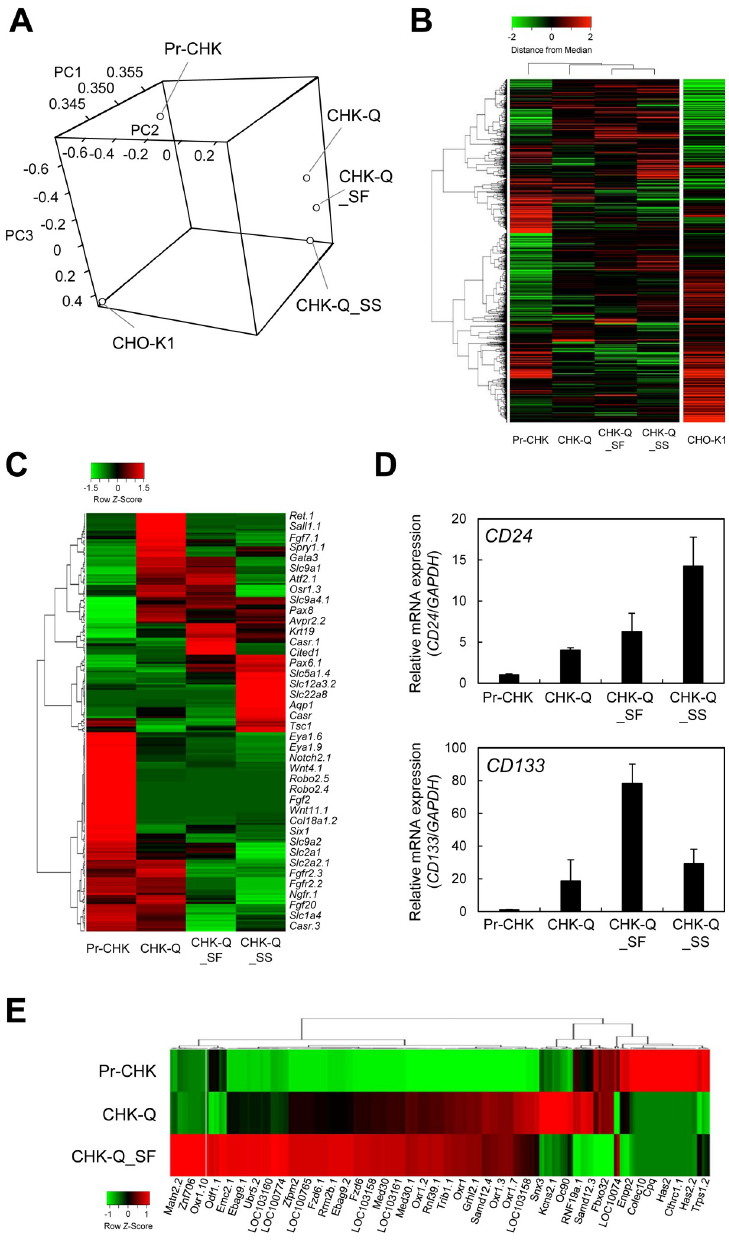
Fig 3. Comparative gene expression analysis using DNA microarrays. (A) Three-dimensional principal component analysis (PCA) for transcriptomic data of pre-immortalized primary cells (Pr-CHK), immortalized cells (CHK-Q), serum-free-adapted cells (CHK-Q_SF), CHK-Q_SS cells that were adapted for serum-free and suspension conditions, and CHO-K1 cells. (B) Heatmap analysis of expression profiles of global genes. Hierarchical clustering was analyzed using the Pearson’s correlation distance/average linkage method. (C) Heatmap analysis of expression profiles of kidney-related genes. (D) Expression analysis of kidney stem cell markers ( CD24 and CD133 ) by quantitative RT-PCR. Data are expressed as mean ± SD ( n = 3). (E) Heatmap analysis of fluctuating genes expressed on chromosome 10 of Chinese hamster.